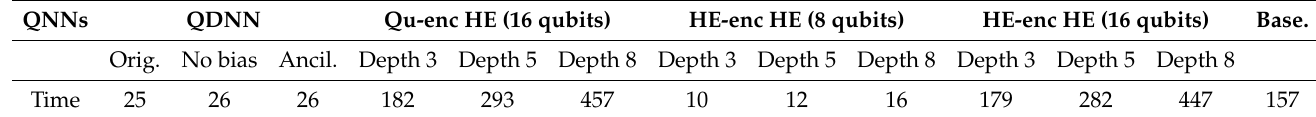
Table 2. Average training time (seconds per epoch) of different QNNs.